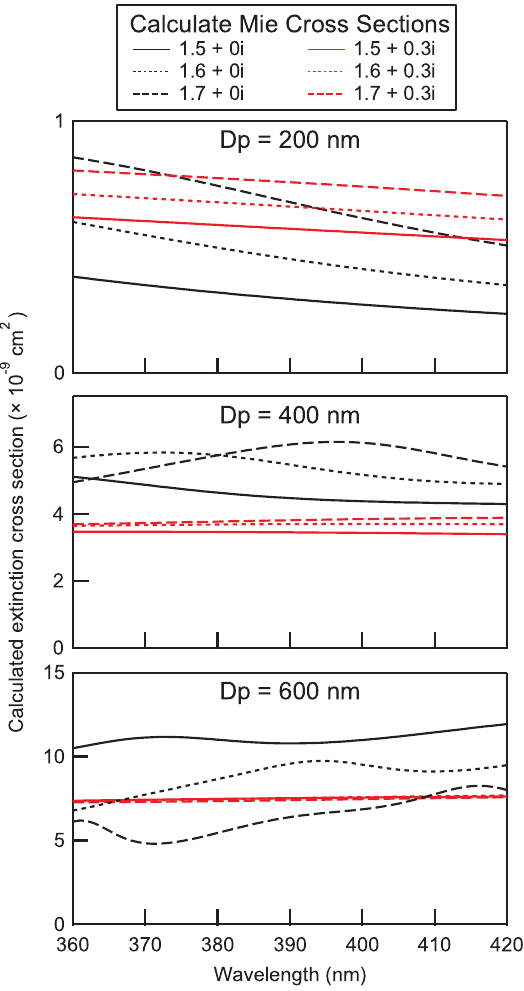
Fig. 11. Theoretical aerosol extinction cross sections for six refrac- tive indices at aerosol diameters of 200, 400, and